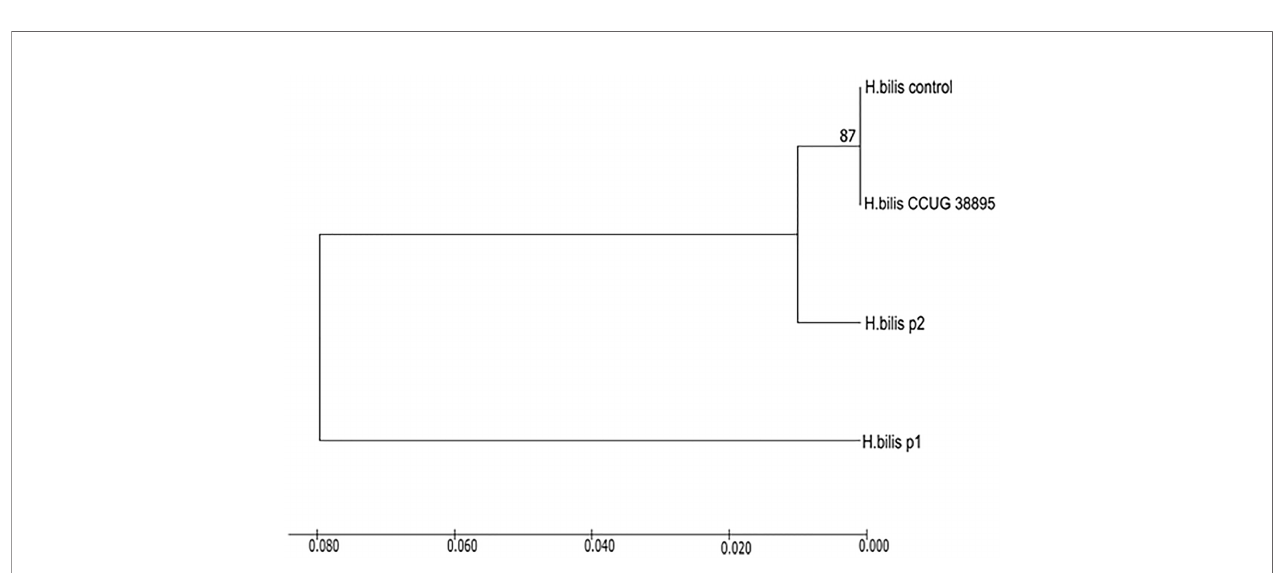
FIGURE 5 | H. bilis identi fi cation in Cases 1 and 2. (A) PCR for Case 2 (1) Case 1 (2), negative control (3), molecular size marker (4), and positive control (5). (B) Sequence alignments of H. bilis 16S ampli fi ed from a control strain, Case 1, Case 2 and reference sequence from H. bilis CCUG 38895.